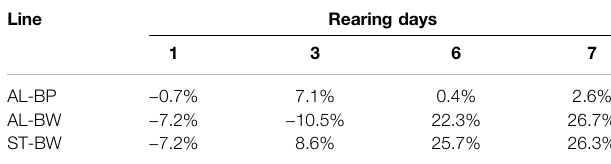
Data are expressed as deviation (%) from the Base population line at standard feeding ration(ST-BP).AL-BP:TheBasepopulationlineat ad-libitum feedingration;AL-BW:The Body weight line at ad-libitum feeding ration; ST-BW: The body weight line at standard feeding ration.